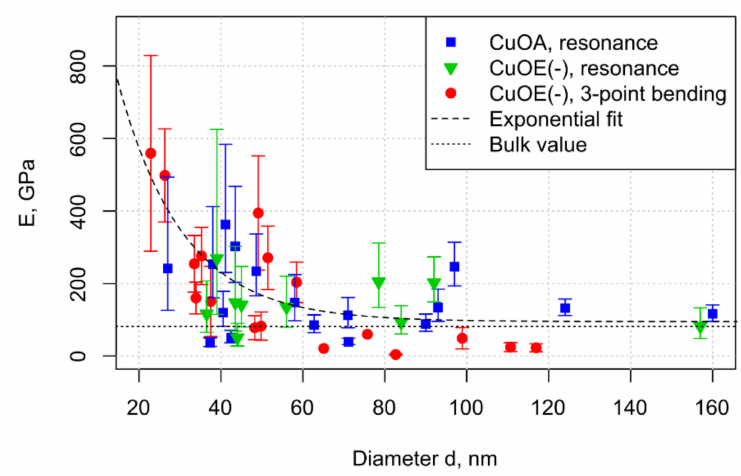
Figure 5. Experimental Young’s moduli from resonance and bending tests obtained for 44 CuO nanowires vs. their mean diameters; CuOA—nanowires synthesized by thermal oxidation (dry air), CuOE(-)—nanowires synthesized in electric field (cathode side, wet air). The dashed line is a guide to the eye; the dotted line is the bulk Young’s modulus determined in [13].